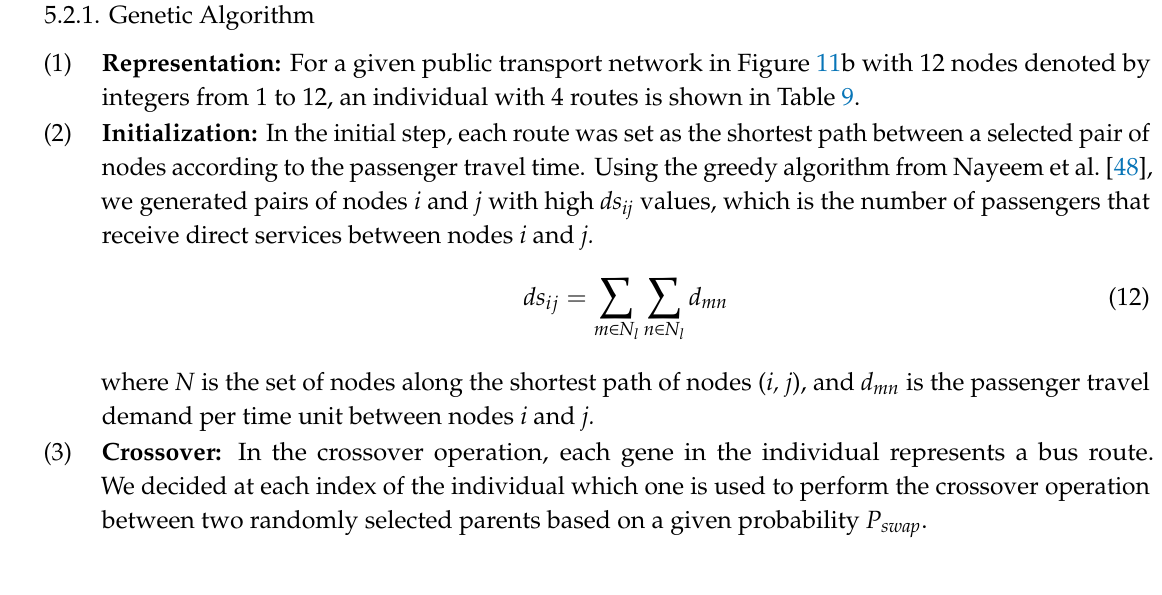
Representation: For a given public transport network in Figure 11b with 12 nodes denoted by integers from 1 to 12, an individual with 4 routes is shown in Table